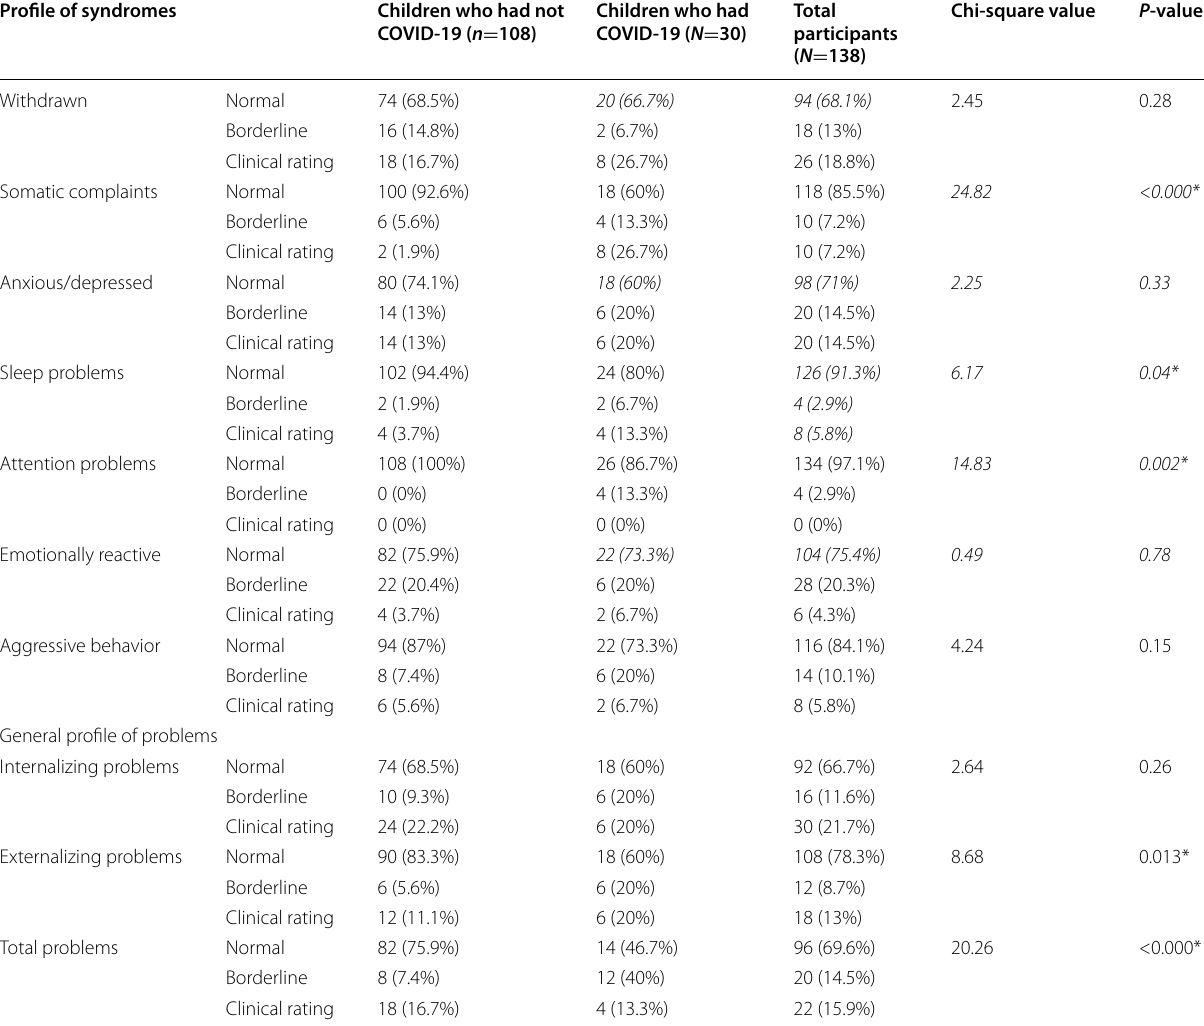
Table 3 CBCL profile of syndromes of studied